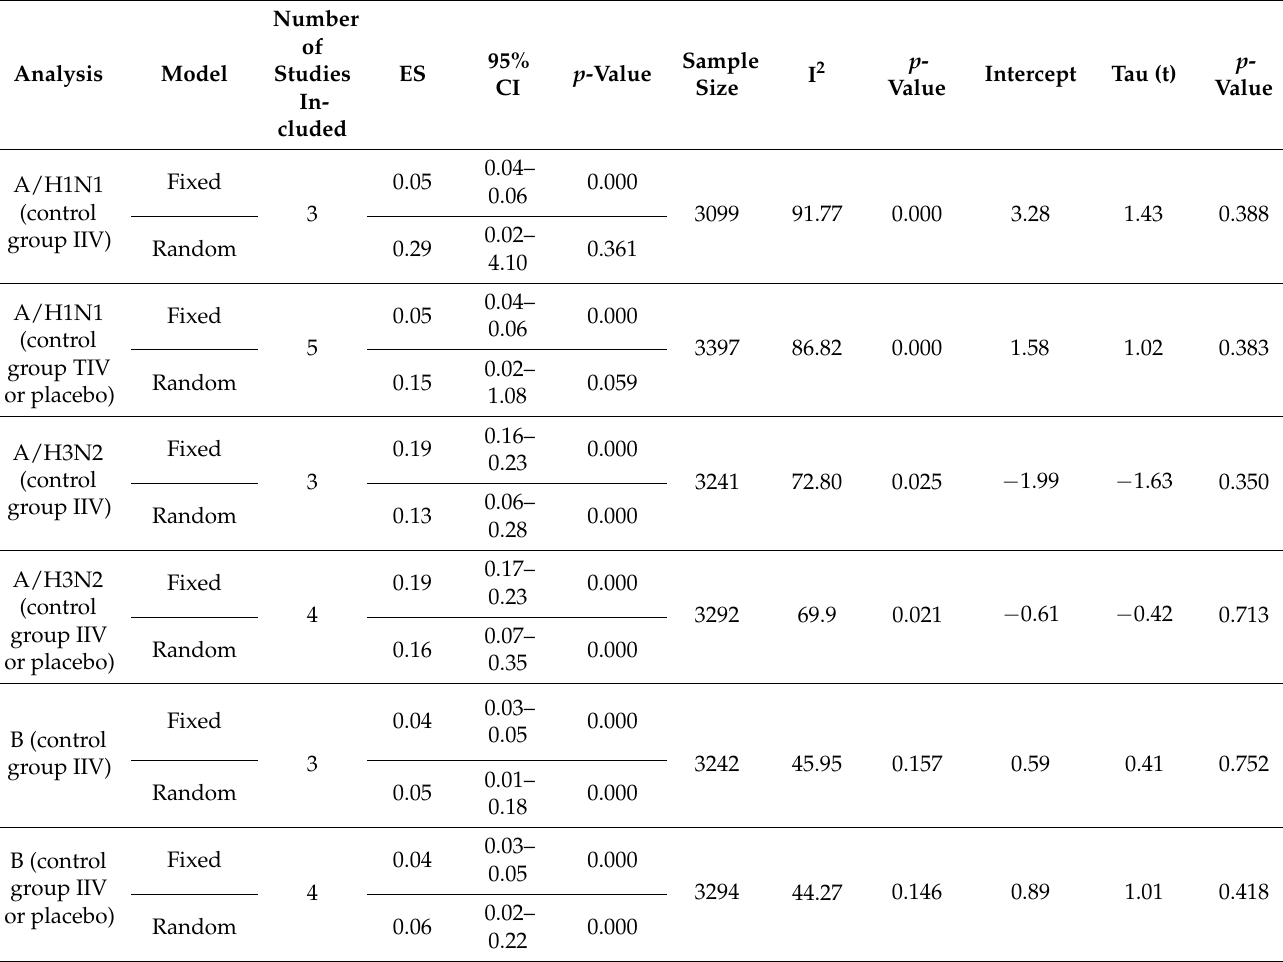
Table 2. Subgroup and sensitivity analysis assessing LAIV efficacy among immunocompromised subjects stratified by influenza serotype. ES: effect size, estimated as odds